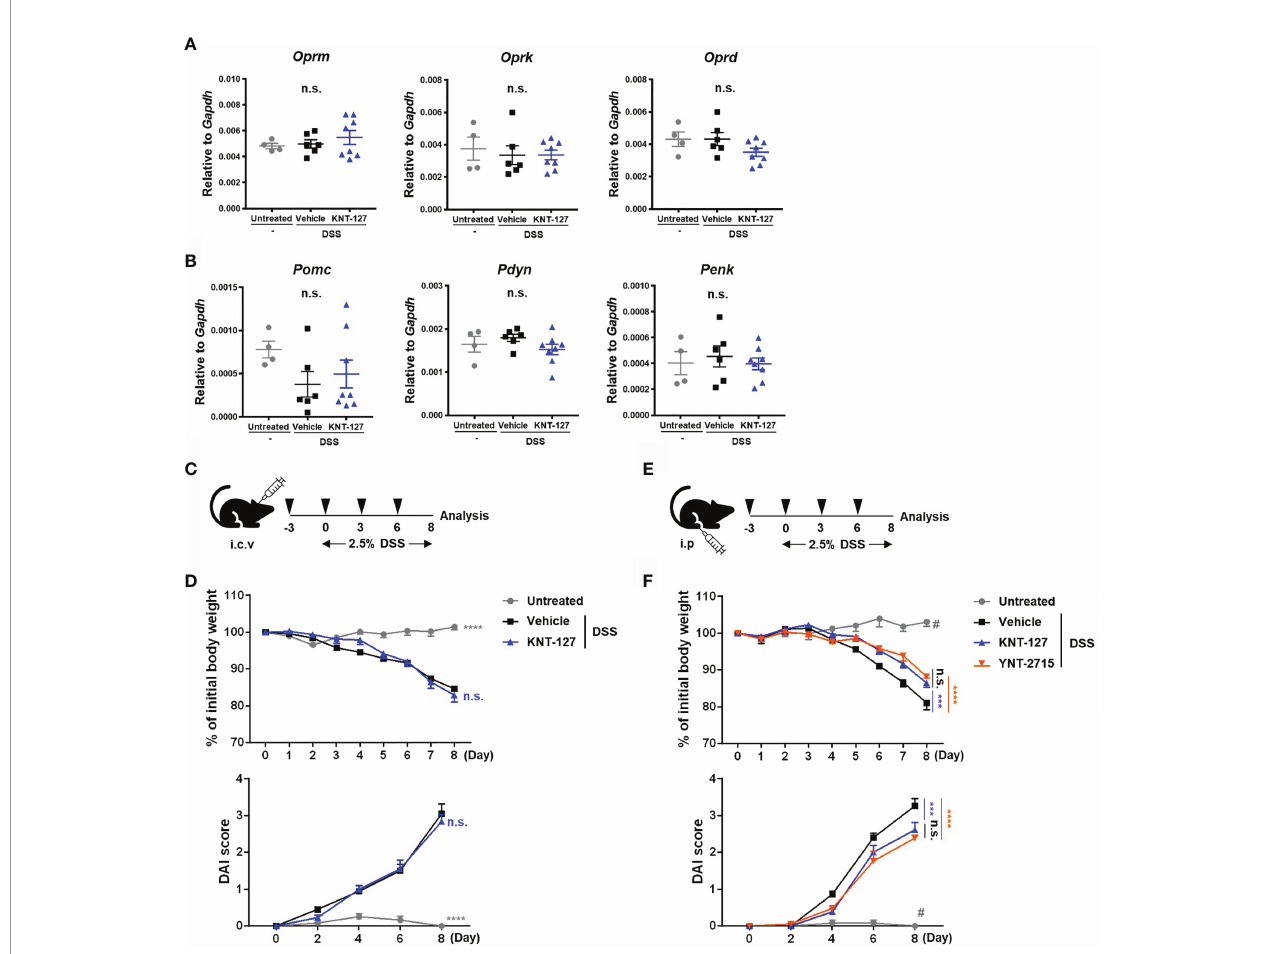
FIGURE 2 | Identi fi cation of the site of KNT-127 activity. The whole brain was collected from colitis mice. The mRNA expression of each gene of interest was normalized to that of GAPDH by calculation of cycle threshold values. (A) mRNA levels of opioid receptors. (B) mRNA levels of endogenous opioid precursors. (C) KNT-127 (5 m g/mouse, n=6) or vehicle (n=6) was administered intraventricularly to mice every 3 days from day -3 to day 6. (D) The percentage of body weight (top). DAI scores (bottom). (E) KNT-127 (5 mg/kg, n=8), YNT-2715 (5 mg/kg, n=8) or vehicle (n=6) was administered intraperitoneally to mice every 3 days from day -3 to day 6. (F) The percentage of body weight (top). DAI scores (bottom). ○ , control; □ , vehicle; △ , KNT-127; and ▽ , YNT-2715 respectively. The data are shown as the mean ± s.e.m. *** P < 0.001; **** P < 0.0001; n.s., not signi fi cant (one-way ANOVA followed by Dunnett ’ s multiple comparisons test, vs vehicle). # P < 0.05 (one-way ANOVA followed by Turkey ’ s multiple comparison test, Untreated vs all other groups). i.c.v., intracerebroventricular; i.p.,